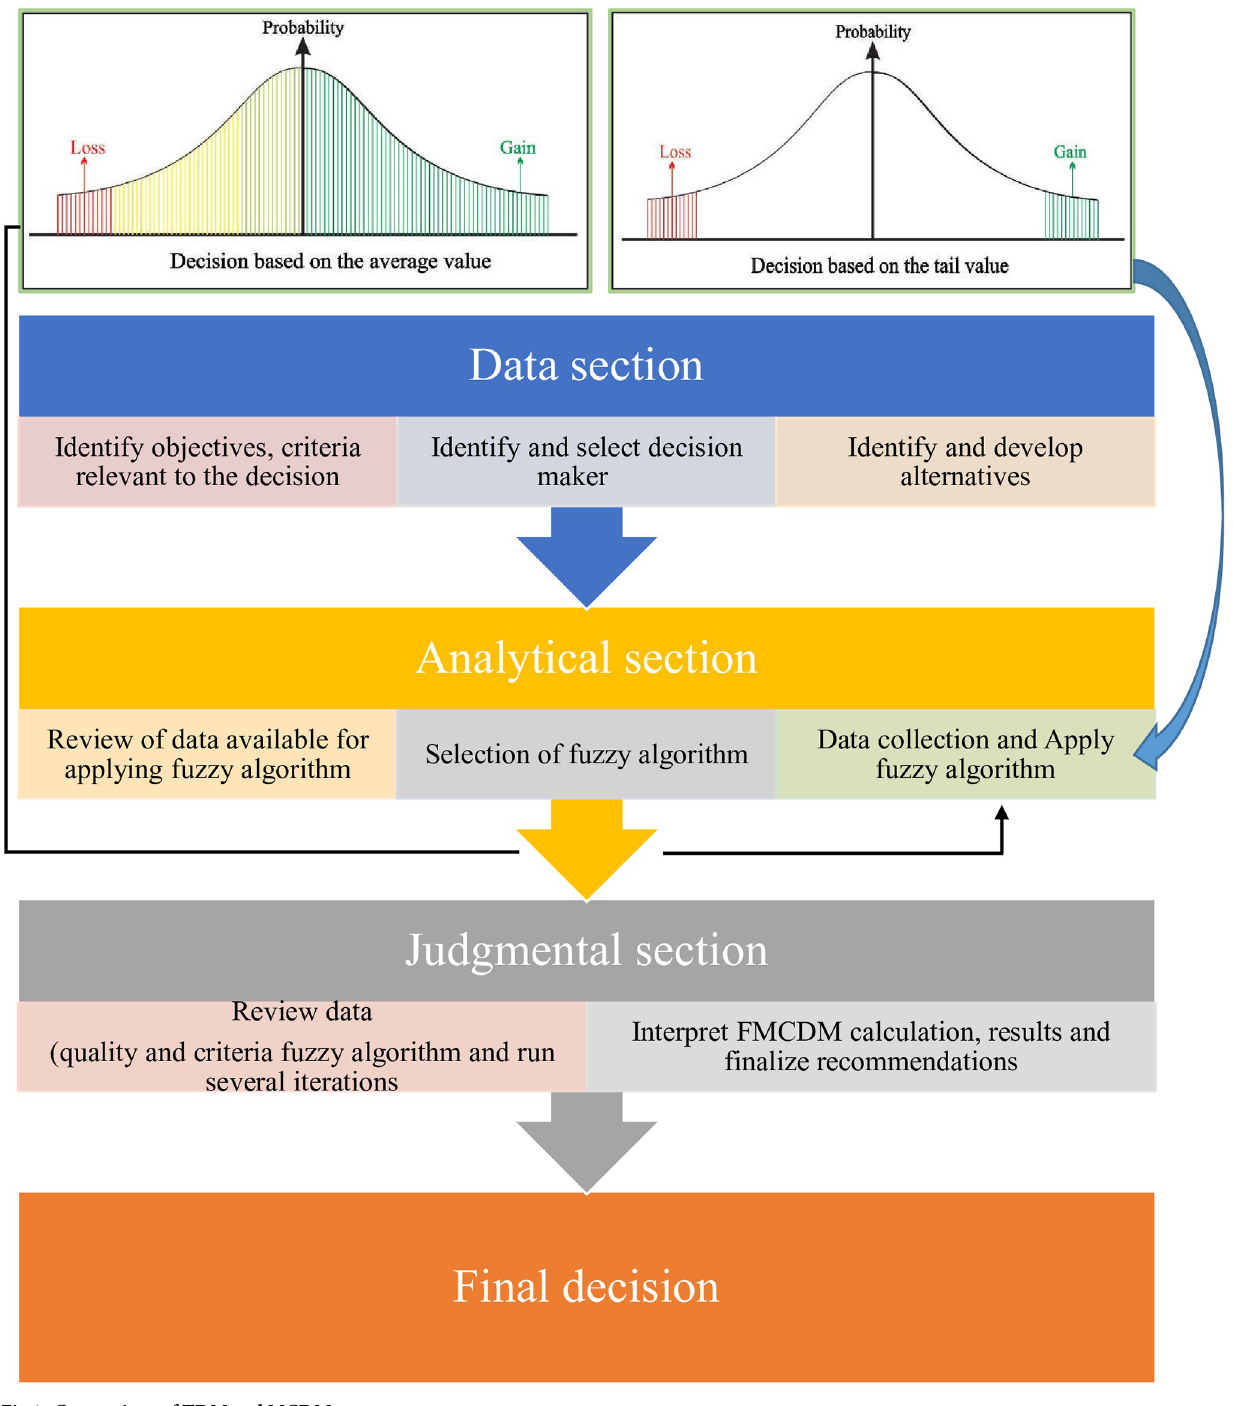
PLOS ONE | https://doi.org/10.1371/journal.pone.0252115 May 27,